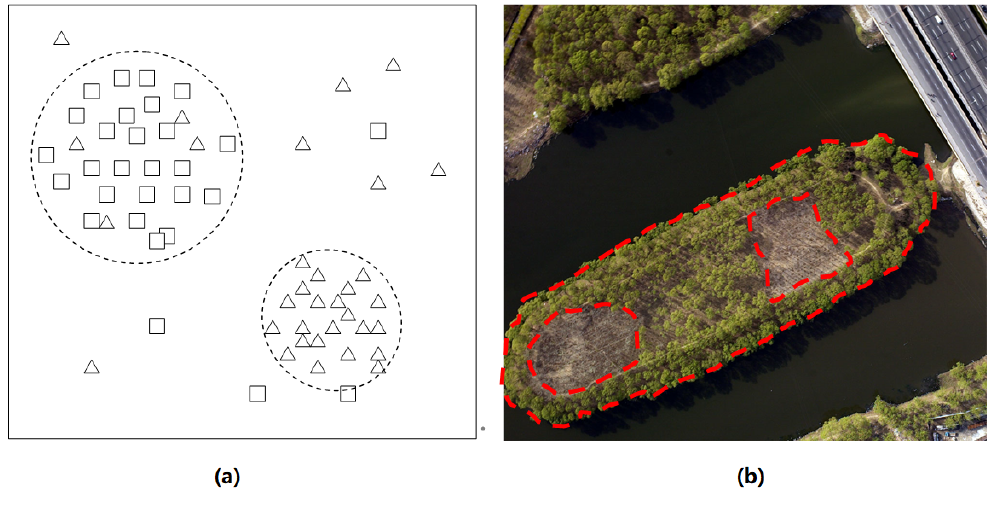
Figure 5. ( a ) Hypothetical ECOs based on Gestalt psychology; ( b ) Woodland: an example of